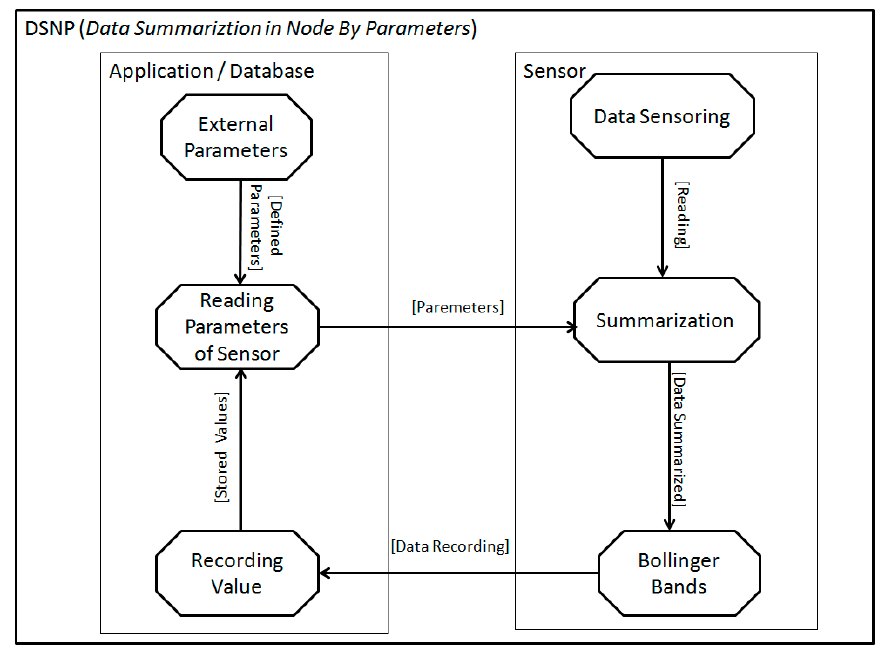
Figure 2. The application proposal using Data Summarization in the Node by Parameters (DSNP).